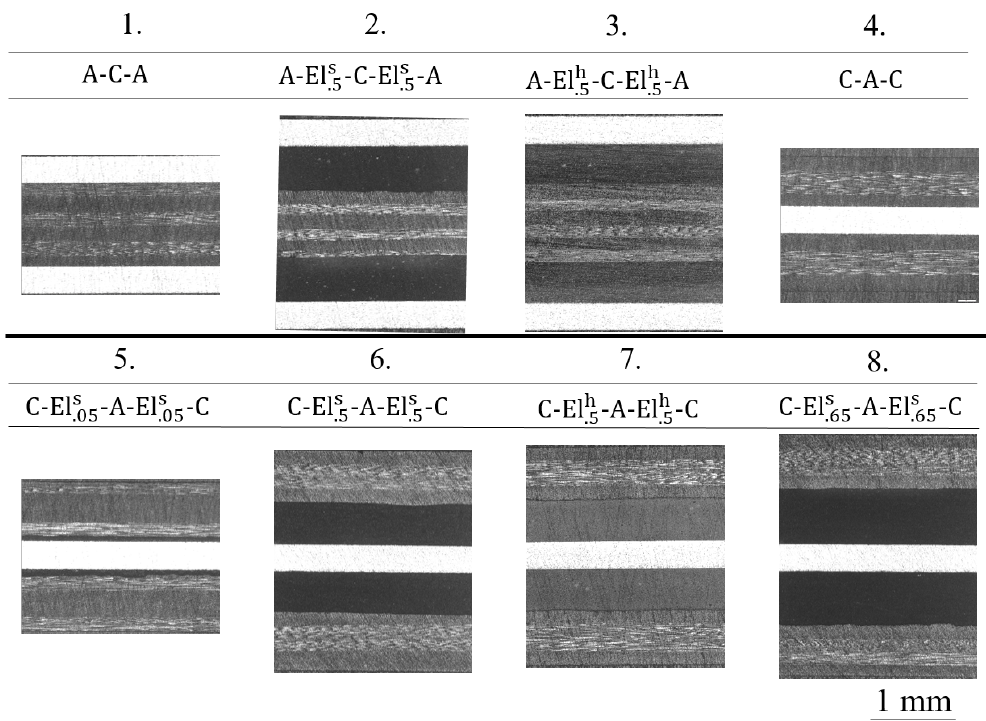
Figure 1. Micrographs of the FML and FMEL lay-ups listed in Table 2. Table 2. FML and FMEL lay-up configurations. Nomenclature for hybrid laminates based on VDI 2014[31]. X z y : X : Material class; y : Thickness; z : Additional information like orientation or different materials within the material class; A: Aluminum; El: Elastomer; C: CFRP; Abbr. lay-up nomenclature will be used to reference the laminate in continuous text and figures.